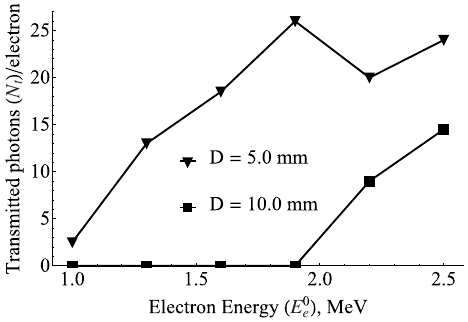
Fig. 2. Intensity of re°ected photons versus the attenuation parameter, for E 0 e ¼ 1 : 6 MeV and E 0 e ¼ 1 : 3 MeV ( a ¼ 0 : 99, g ¼ 0 : 98, D ¼ 5 : 0 mm).